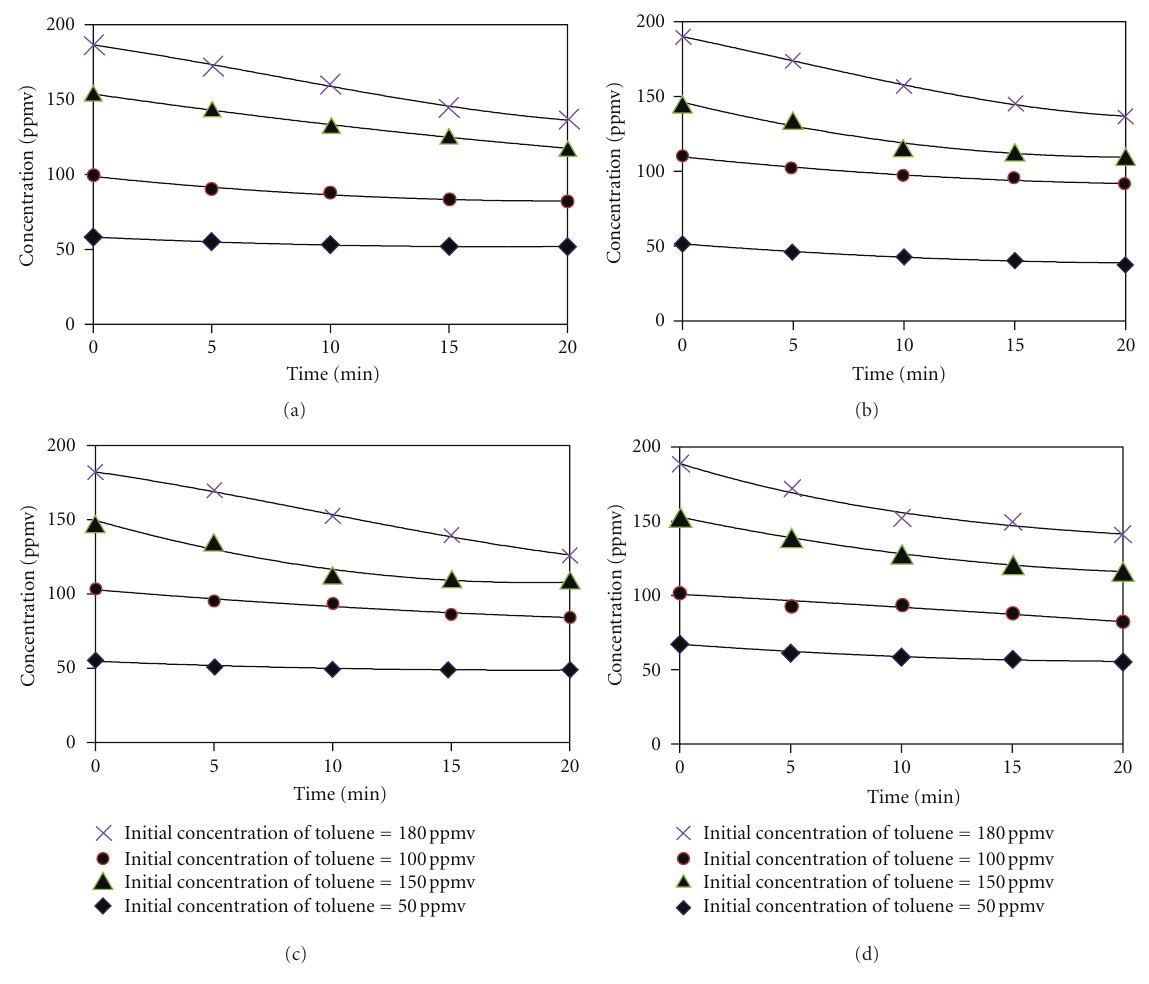
Figure 5: Photocatalytic degradation of toluene with various Fe-TiO 2 catalysts using UV-LED light source. (a) TiO 2 , (b) 0.3% Fe-TiO 2 , (c) 0.5% Fe-TiO 2 , and (d) 0.7% Fe-TiO 2